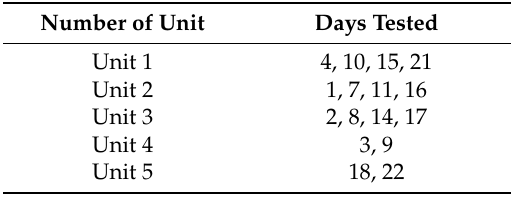
Table 3. Types and Heater Voltages of MOS sensors.